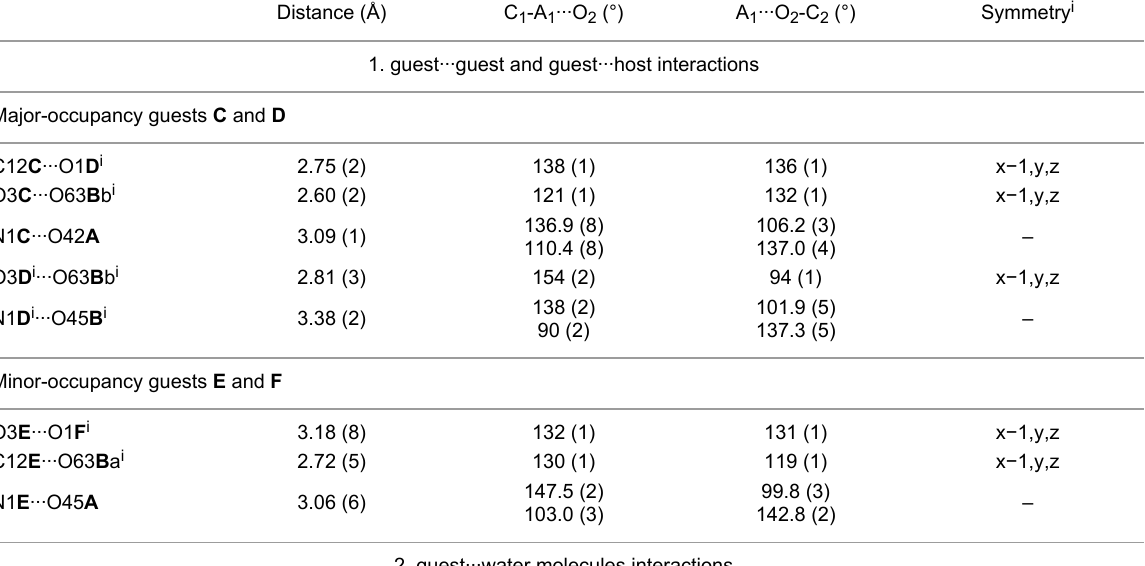
Table 1: H-bond distances of β -CD–L-NAcTrp complex: (1) between guest molecules themselves and with the host (2) with water molecules, (3) be- tween structural water molecules and the host. Distance